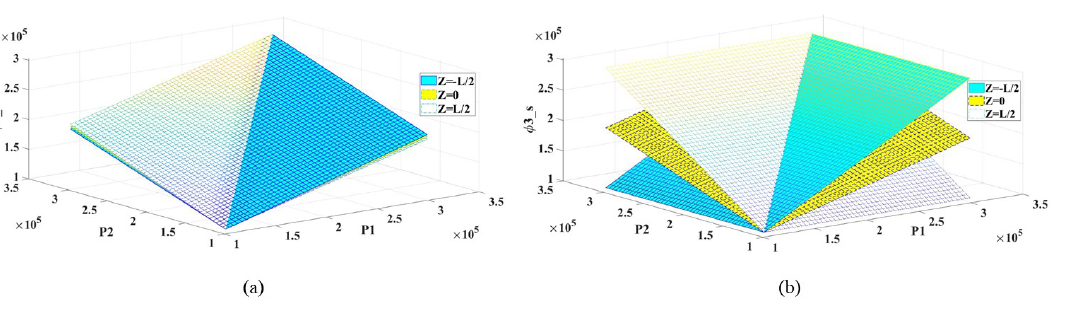
Figure 9. Influence of the pressure function. ( a ) End sealing under the short bearing. ( b ) No-end sealing under the finite length bearing.